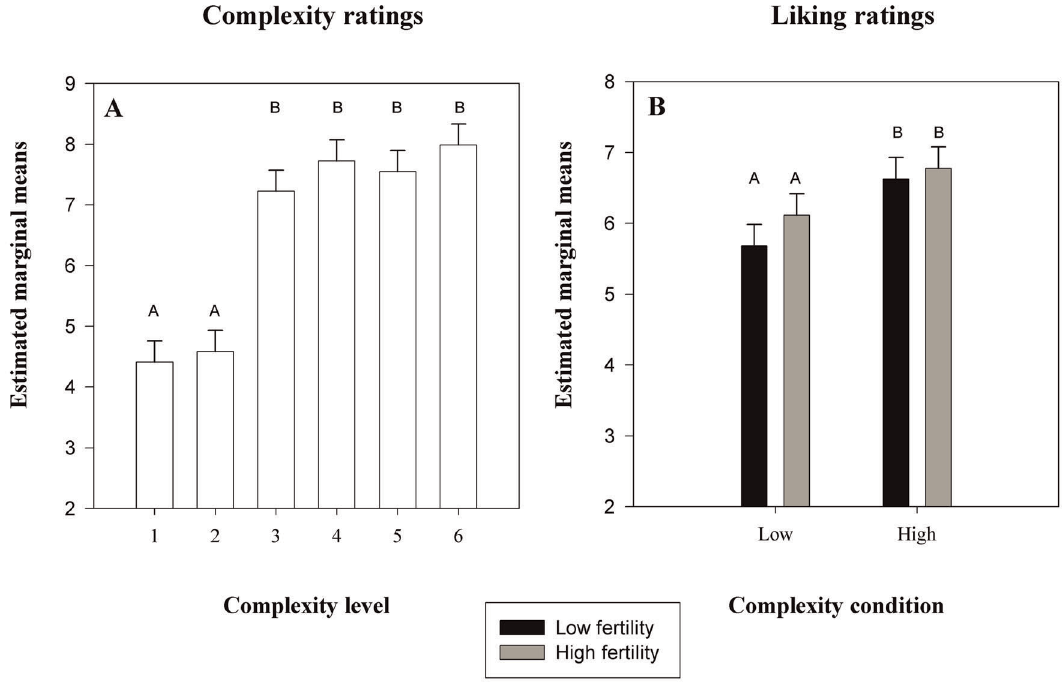
Figure 2. Estimated marginal means 6 SE of women’s responses to the musical stimuli. Complexity ratings for the different complexity levels 1–6 (A), and liking ratings for low and high musical complexity at the two cycle stages (B) are shown. Mean responses sharing the same letter are not significantly different.